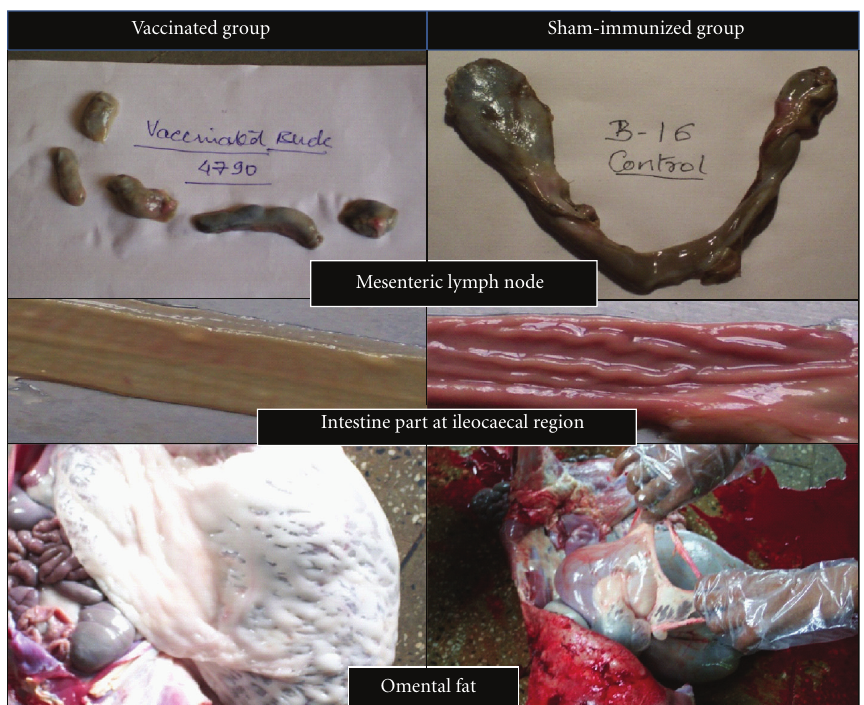
Figure 1: Pictorial presentation for comparative gross lesions (in mesenteric lymph nodes and intestines) and presence of omental fat in vaccinated and sham-immunized